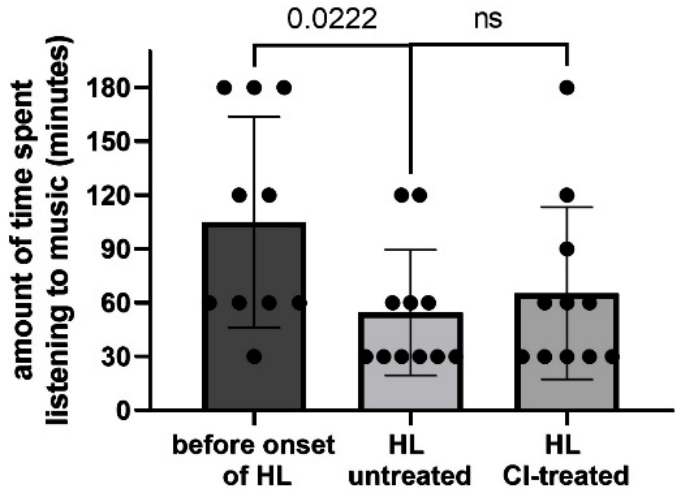
Figure 1. Distribution of amount of time of patients listening to music before onset of hearing loss (HL), when HL occurred with treatment and after CI rehabilitation and Music Therapy.